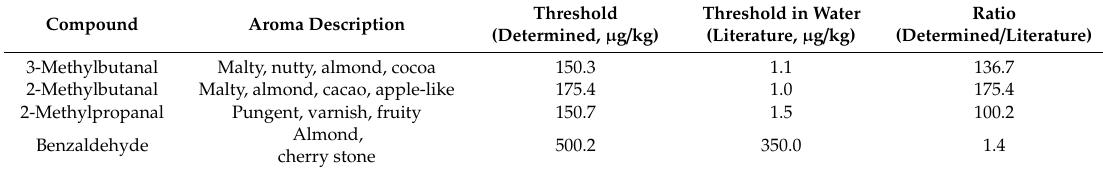
Table 1. Detection thresholds of 3-methylbutanal, 2-methylbutanal, 2-methylpropanal, and benzaldehyde. Compound Aroma Description